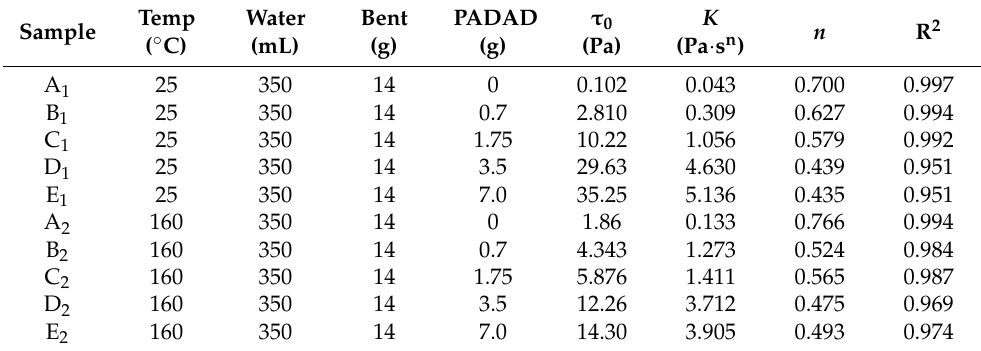
Table 2. Rheological parameters τ 0 , K , and n of drilling fluid contain different concentrations